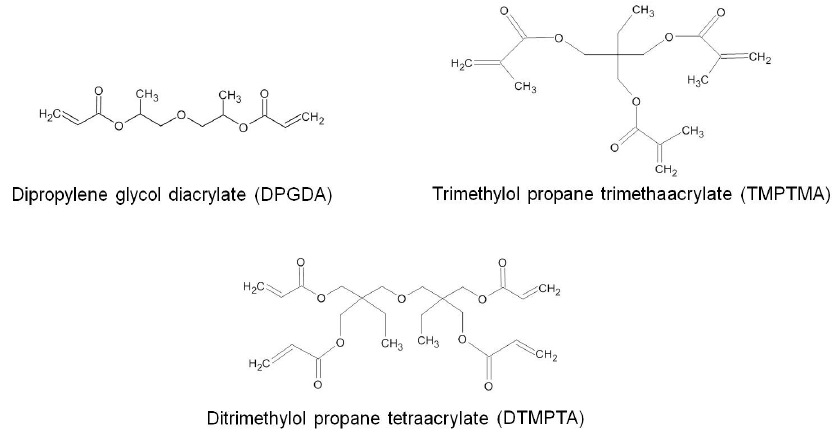
Figure 1. Molecular structures of DPGDA, TMPTMA, and DTMPTA coagents.